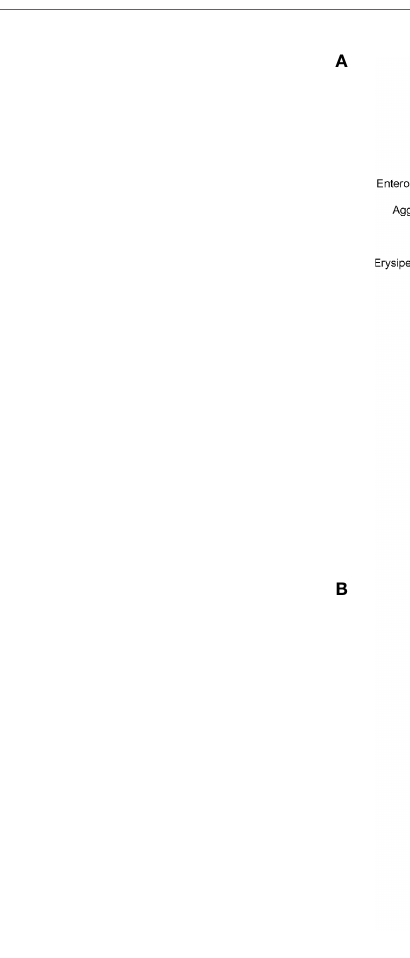
FIGURE 4 | (A) Spearman correlations among the 15 signi fi cantly different genera in pre-CDIs (n=22) and hepatic cirrhosis controls (n=21). The microbial genera enriched in pre-CDIs ( Enterococcus ) were negatively correlated with control-enriched genera. (B) Prediction of the key genera in the gut microbiota of pre-CDI patients and controls with hepatic cirrhosis. Receiving operational curve analysis for Intestinibacter , Allisonella and Haemophilus , the area under the curve (AUC) was 0.81. Diagonal lines represent random classi fi cation